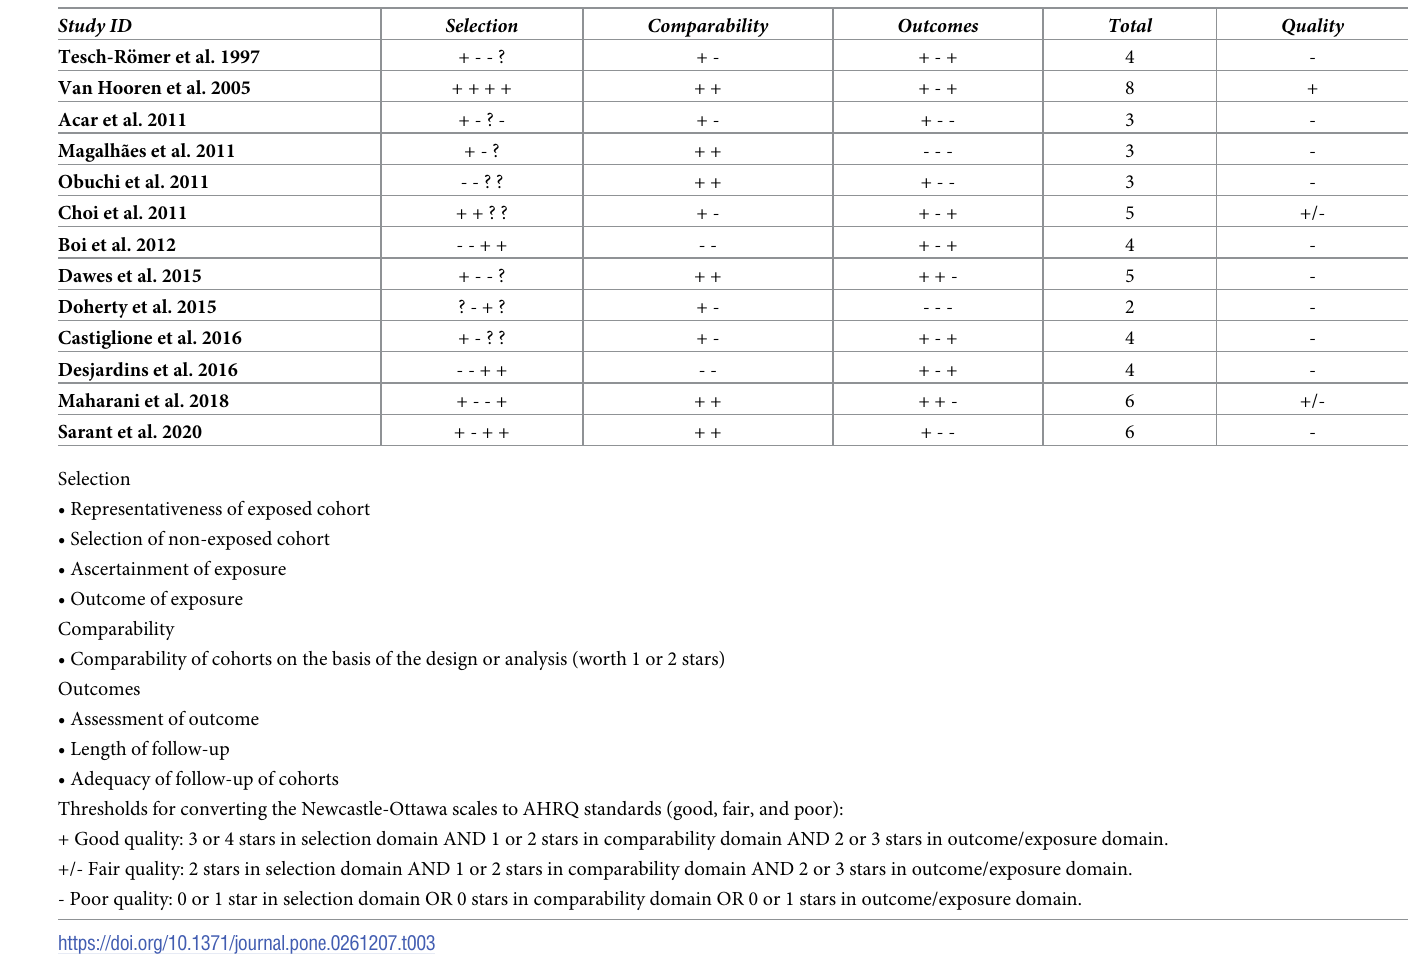
Table 3. Newcastle-Ottawa Scale for assessing non-randomized